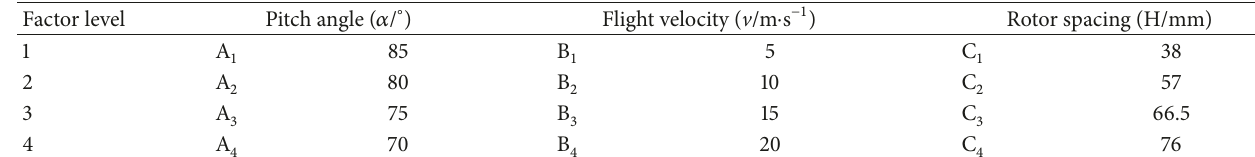
Table 1: Forward flight aerodynamics factor-level form.